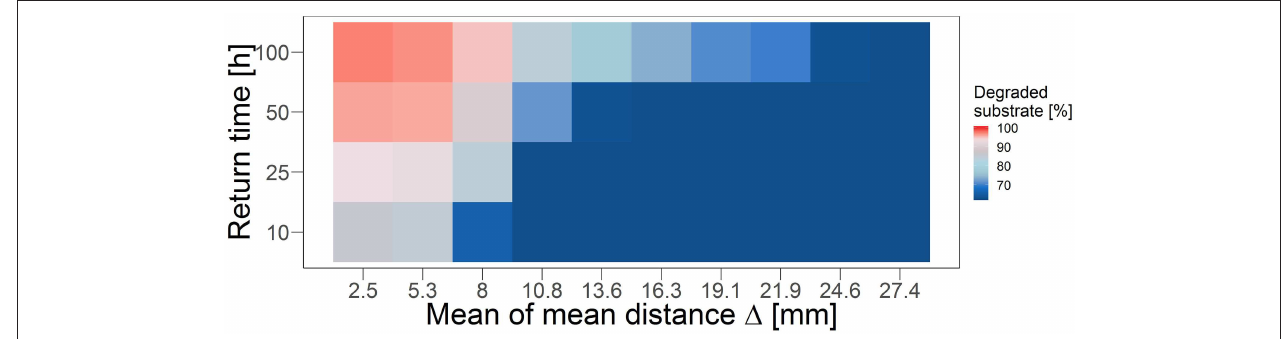
FIGURE 6 | Functional resistance under recurrent disturbance events with different return intervals over mean of mean distance 1 of a number of disturbance patterns equivalent to the number of applied disturbance events with respective disturbance size and fragmentation. Colors represent substrate degradation within 4,000h of simulation time in relation to the undisturbed reference degradation performance (indicated by 100%). Note that 1 is not normally distributed and thus the amount of data points underlying each box can differ.